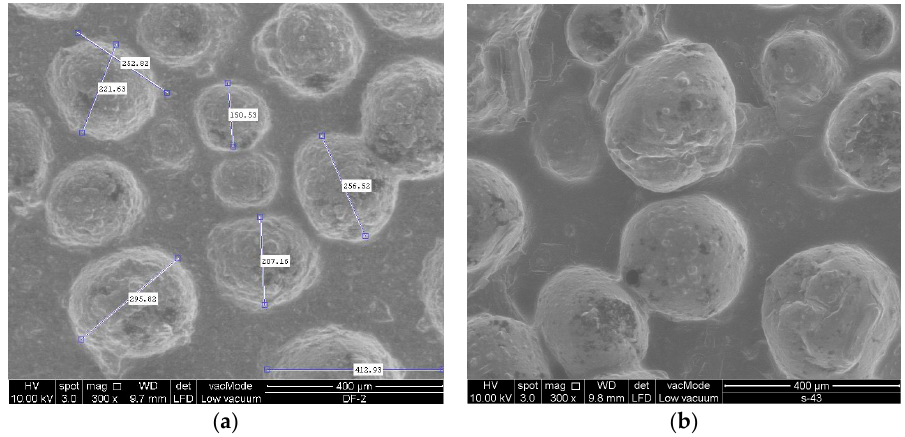
Figure 4. ( a ) SEM image of ADN produced via ultrasound sonication, following by coating with 5% of PS. The particles diameter ranges from 150 µm to 295 µm; ( b ) SEM image of ADN sonicated and coated with HTPB. The particle diameter ranges from 155 µm to 305 µm.